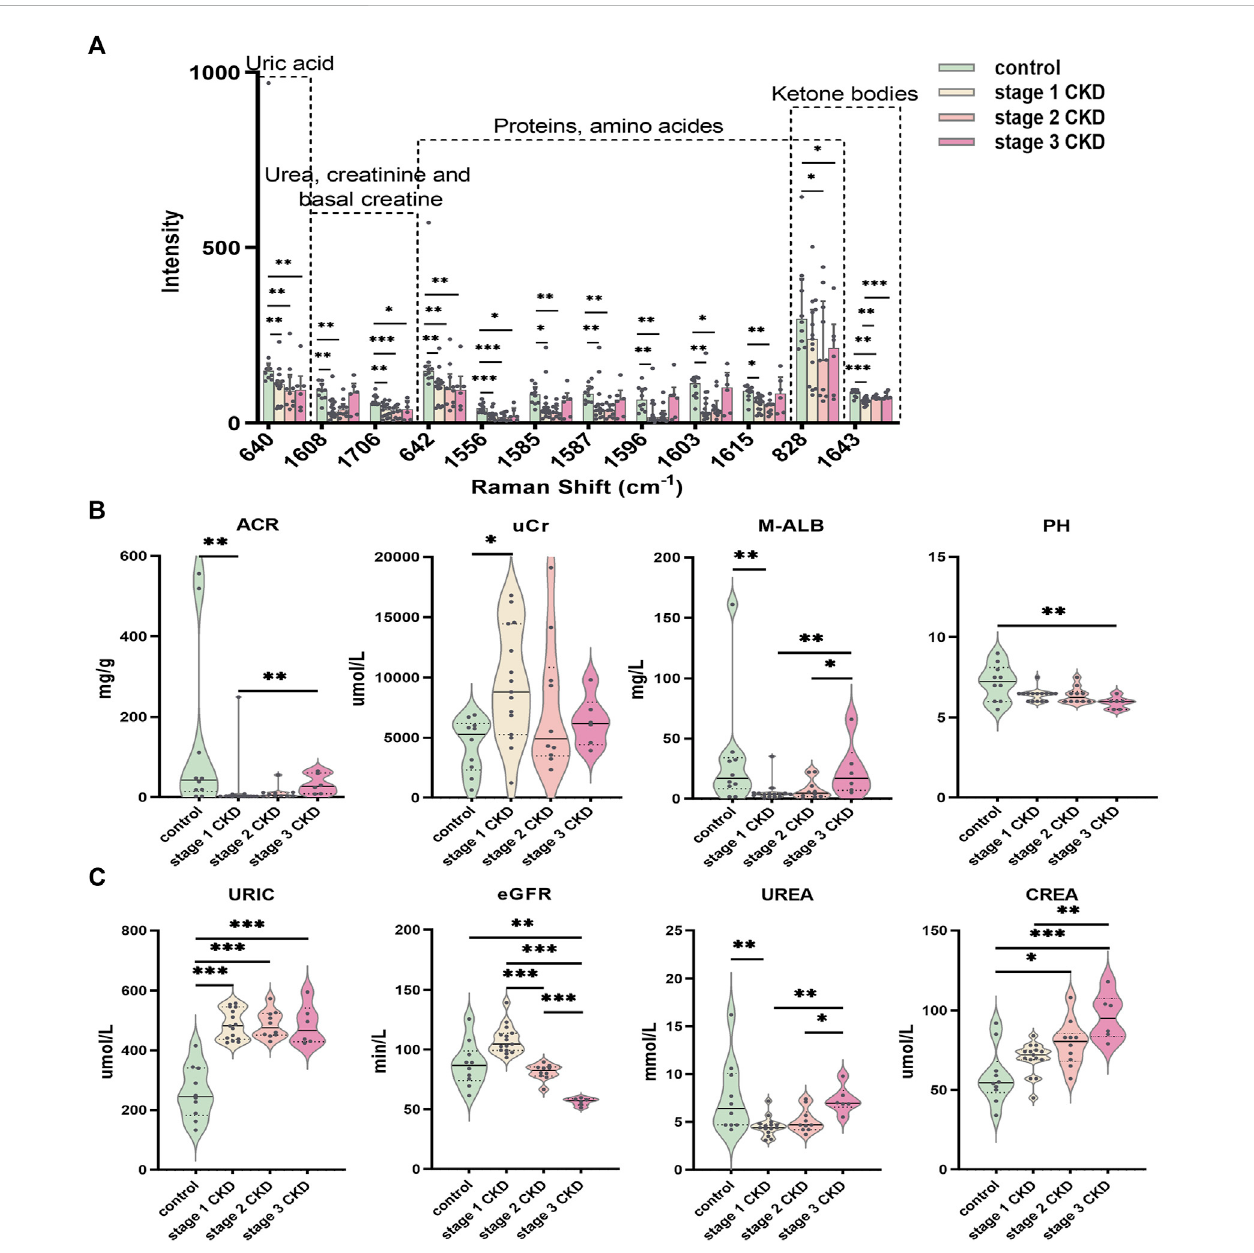
FIGURE 4 Statistically signi fi cant Raman spectral peak maps and evaluation of identi fi ed clinical indicators of renal function (A) Statistical analysis showed that the intensityoftheuricacidpeak,urea,creatinine,proteins/aminoacids,adenine/serine,andketonebodiesintheurineoftheCKDsubgroupandcontrolgroup;a Normally distributeddataareexpressedasmean±standarddeviation,andnon-normallydistributeddataareexpressedasmedianandinterquartilerange. (B) The piano chart of urine renal function evaluation indexes (ACR, UCR, M-ALB, pH) in different stages of CKD with HUA and the control group; (C) The pianodiagramofthecomparisonofdifferentCKDstageswithHUAandtheevaluationindexesofperipheralbloodrenalfunction(uric,eGFR,urea,crea)inthe control group; The solid line in the piano chart is the median, and the dotted line is the upper and lower quartiles, * p < 0.05, ** p < 0.01, *** p <